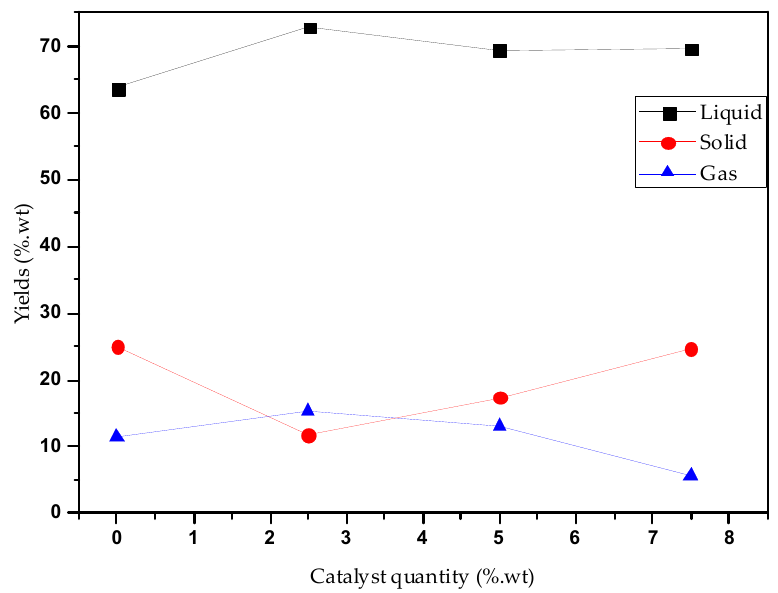
Figure 15. Effect of catalyst quantity on the catalytic upgrading of WEEE plastics. Nunome et al. studied the generation behavior of tar (PAH) during pyrolysis of ABS and concluded that PAHs form due to incorporation of C 2 and C 2 H 2 units and that they were formed mostly by nitrogen-containing hetero-PAHs, oxygen-containing hetero-PAHs, and PAH’s. They did not use any catalysts but used temperatures greater than 700 ◦ C [87]. The same behavior was found for the WEEE plastic bio-oil in this work, but the surface area provided by the catalyst was responsible for the increase in those types of reactions, explaining why there was a reduction of gas yields with increasing bed height. It was observed that there was an increase in char generated, suggesting that the increased bed height may allow some reflux to happen, effectively increasing the residence time of the process as a whole, including affecting the production of char in reactor R-1. Zhang et al. conducted 2-stage pyrolysis of LDPE using activated carbon as a catalyst, and they found that using a catalyst of high surface area and lower micropore structure increases formation of aromatic compounds and PAHs. They reported that chemical activation enlarged pore volume but reduced micropore structure. There were medium gas yields, though (30%), suggesting that smaller products of reaction got through the porous structure of the catalyst, different from ABS. The chain radicals formed by LDPE are indeed much smaller than ABS pyrolysis products, and the gas composition revealed an increased presence of hydrogen. A similar behavior was observed for the higher temperature of the pyrolysis process of LDPE, producing mainly mono-aromatic and double-ring aromatics such as naphthalene